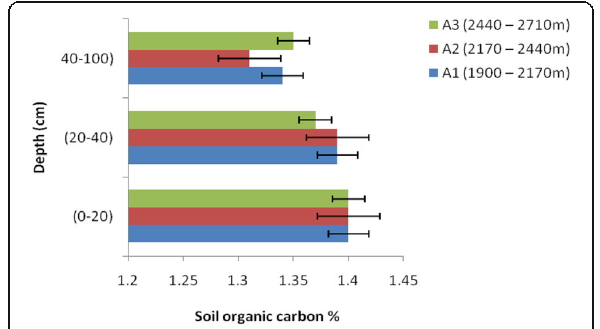
Fig. 2 Depthwise variation of soil organic carbon (%) at three